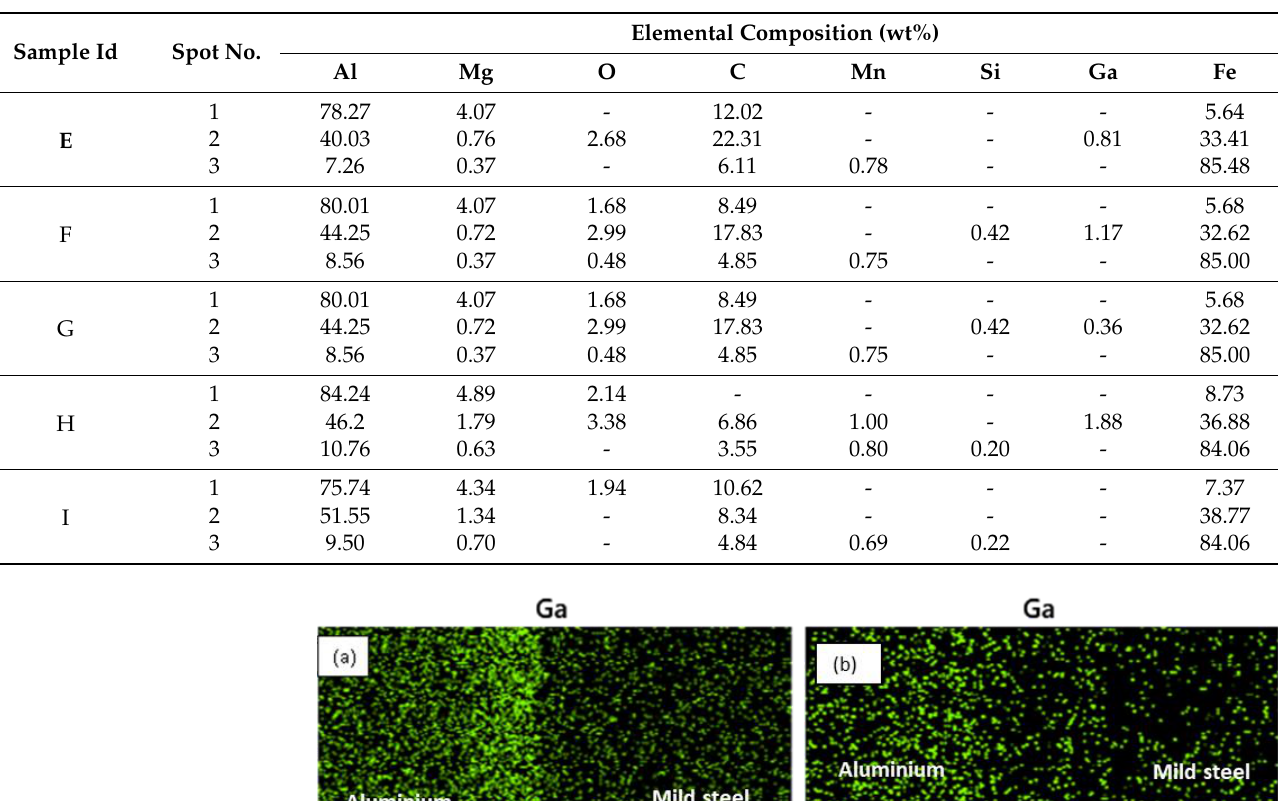
Table 3. Elemental composition of different sections of the joint.